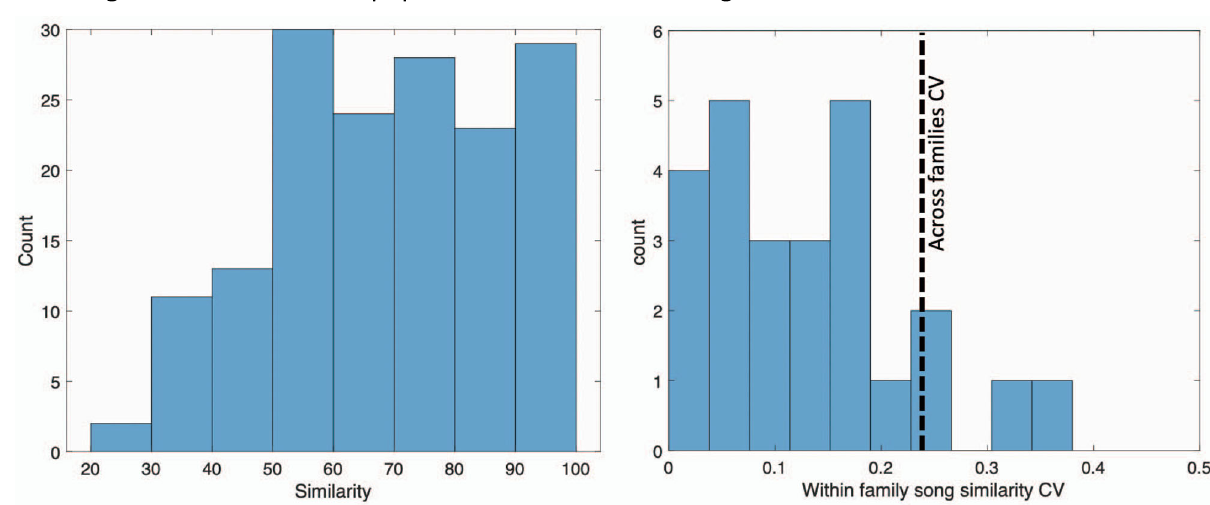
Fig. 1 Distribution of song similarity between pupils and their tutors. a Histogram of song similarities between 160 pupils and their tutors. b Analysis of variance in song similarity between and within families. Data include 24 families with more than one clutch with males. Similarity scores were averaged within clutch members and coef fi cient of variance (CV = 0.14 ± 0.02) of similarity scores were calculated across clutches. CV of the same data (averaged within clutches) across families = 0.24 is presented as a dotted line. Source data for this fi gure is in Supplementary Data File